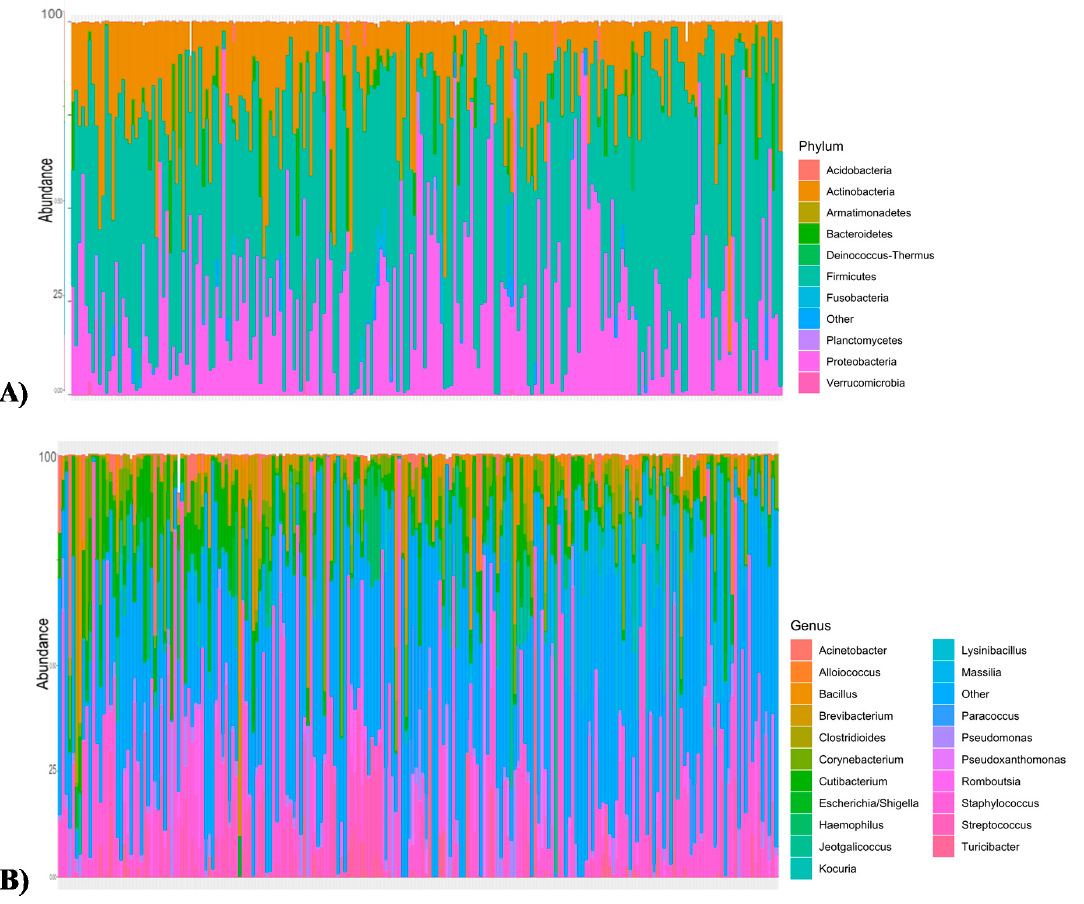
Figure 1. Barplot of taxonomic composition showing the relative abundance of the milk bacterial community in the Churra sheep breed at the phylum level ( A ) and at the genus level ( B ). Each bar represents a subject and each coloured box a bacterial taxon.